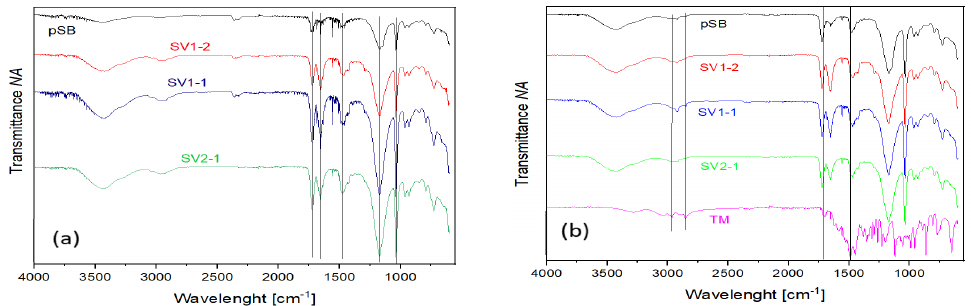
Figure 4. FTIR spectra of ( a ) non-drug-loaded and ( b ) TM-loaded pSB-co-pVP and pSB networks.